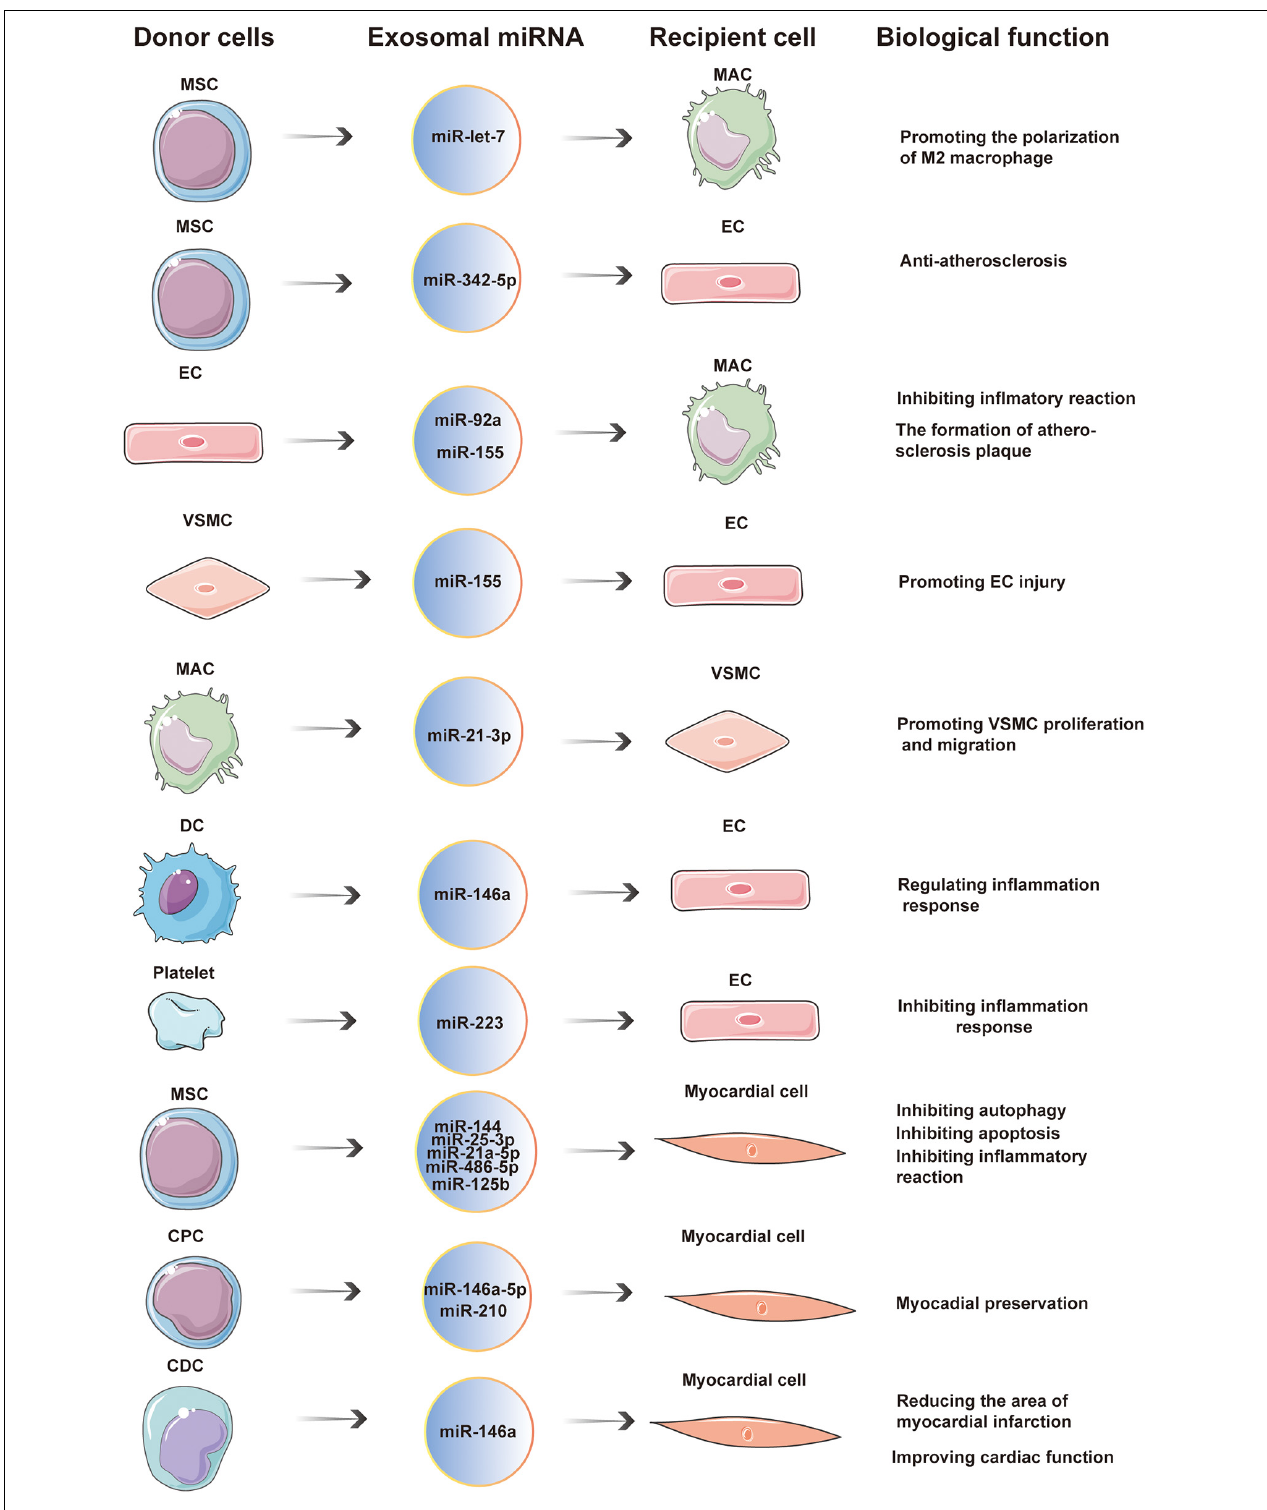
FIGURE 3 | Exosomal miRNAs are widely involved in cardiovascular diseases. In the occurrence and development of cardiovascular diseases, exosomal miRNA is an important way of communication between cells. Donor cells secrete exosomal miRNAs which are taken up by recipient cells. The entry of exosomal miRNA into recipient cells exerts a wide range of biological effects through post-transcriptional regulation.